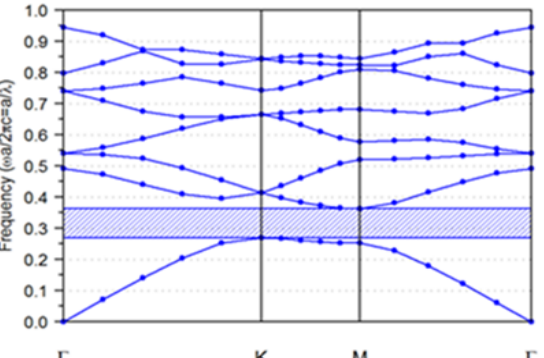
Figure4: Band diagram for TM polarization in a triangular lattice of AlGaAs rods